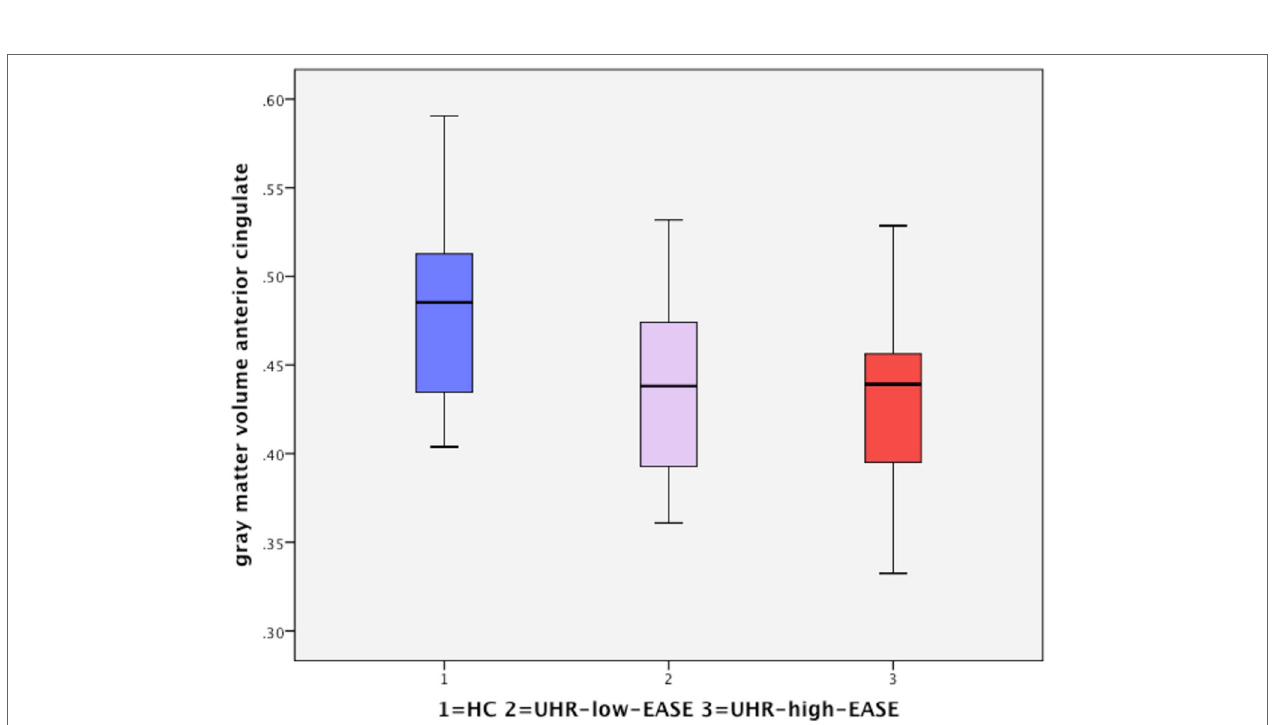
FIGURE 2 | Boxplot showing gray matter volume in the anterior cingulate in the three groups: HC (healthy controls), UHR-low-Examination of Anomalous Self- Experiences (EASE), and UHR-high-EASE. Values on the y -axis refer to mm 3 per